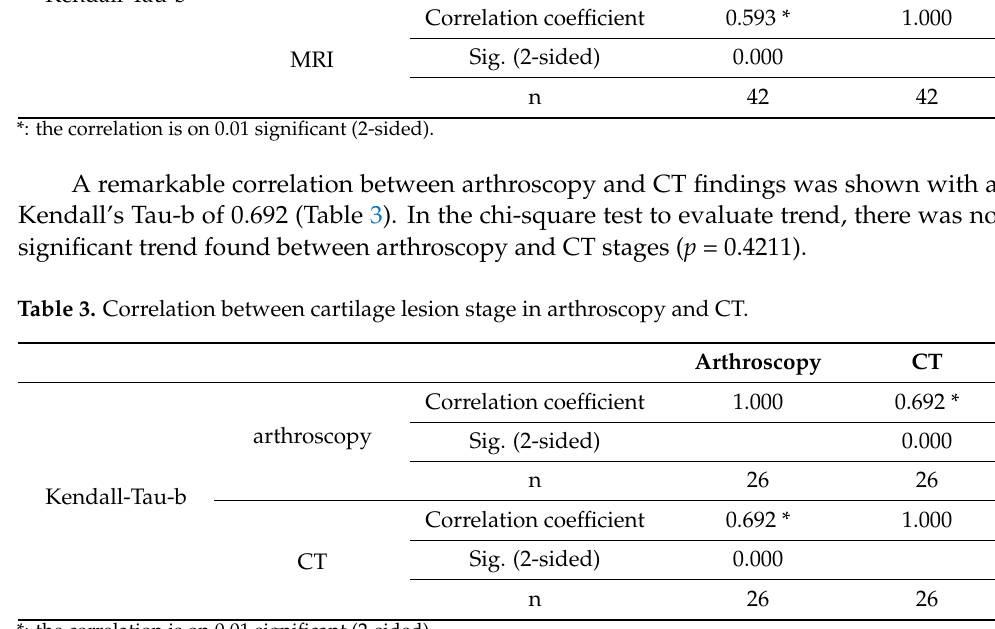
Table 2. Correlation between cartilage lesion stage in MRI and arthroscopy. Arthroscopy MRI Correlation coefficient 1.000 0.593 * arthroscopy Sig. (2-sided) 0.000 n 42 42 Kendall-Tau-b Correlation coefficient 0.593 * 1.000 MRI